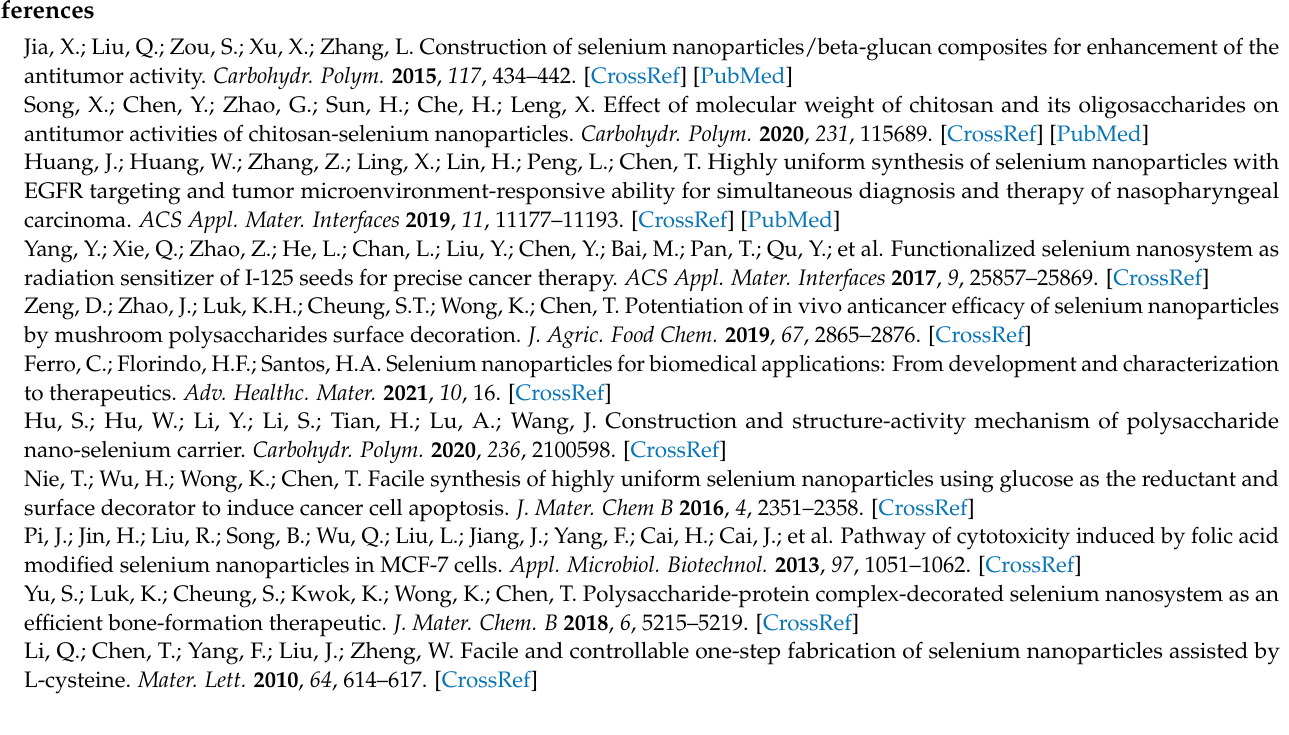
zation of SeNPs system; Figure S3: Photographs of aqueous solution. Figure S4: Variation in particle size; Figure S5: Changes in particle size; Figure S6: Changes in UV-vis absorption spectra; Figure